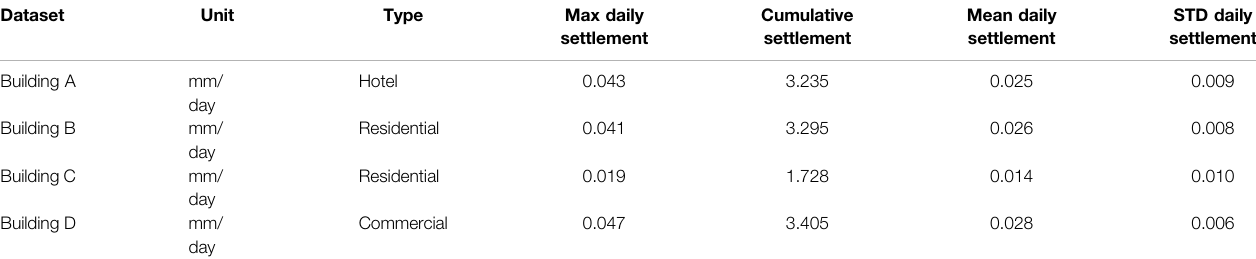
TABLE 1 | Description of the foundation settlement dataset of the four case study